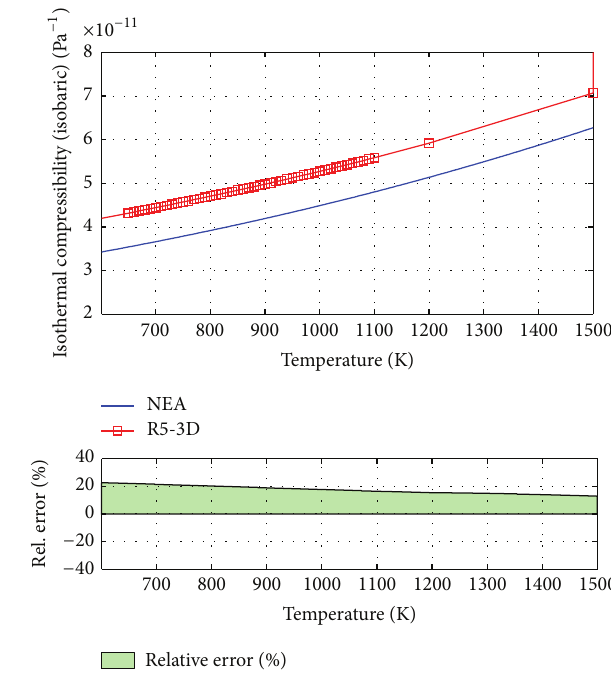
Figure 8: Lead liquid specific volume, original R5-3D “tpf” file versus NEA report.